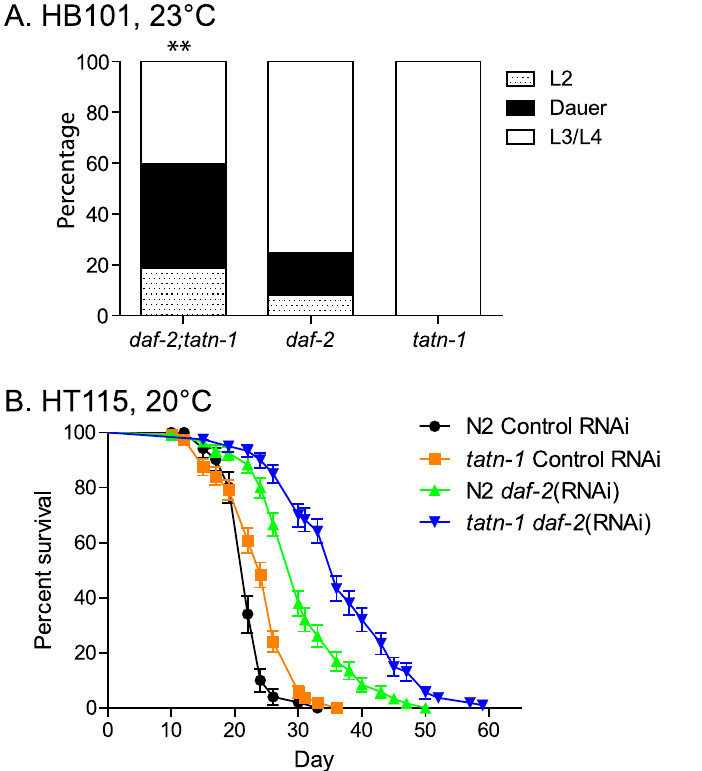
Figure 3. The tatn-1 mutant enhances dauer formation and lifespan of worms with impaired daf-2 /IGFR signaling. (A) Enhanced dauer formation by daf-2(e1368); tatn-1(baf1) compared to daf-2(e1368) grown at 23 u C for 3 days. ** p , 0.01 by Fisher’s exact test. (B) tatn-1 extends the lifespan of worms treated with daf-2 RNAi from day 1 of adulthood. The mean survival for N2 control RNAi, tatn-1(baf1) control RNAi, N2 daf-2(RNAi) , and tatn-1(baf1) daf-2(RNAi) are 22.0, 24.0, 30.5, and 37.0 days, respectively. p , 0.001 for N2 vs. tatn-1 on control RNAi and N2 daf-2(RNAi) vs. tatn-1 daf-2(RNAi) by log-rank test.